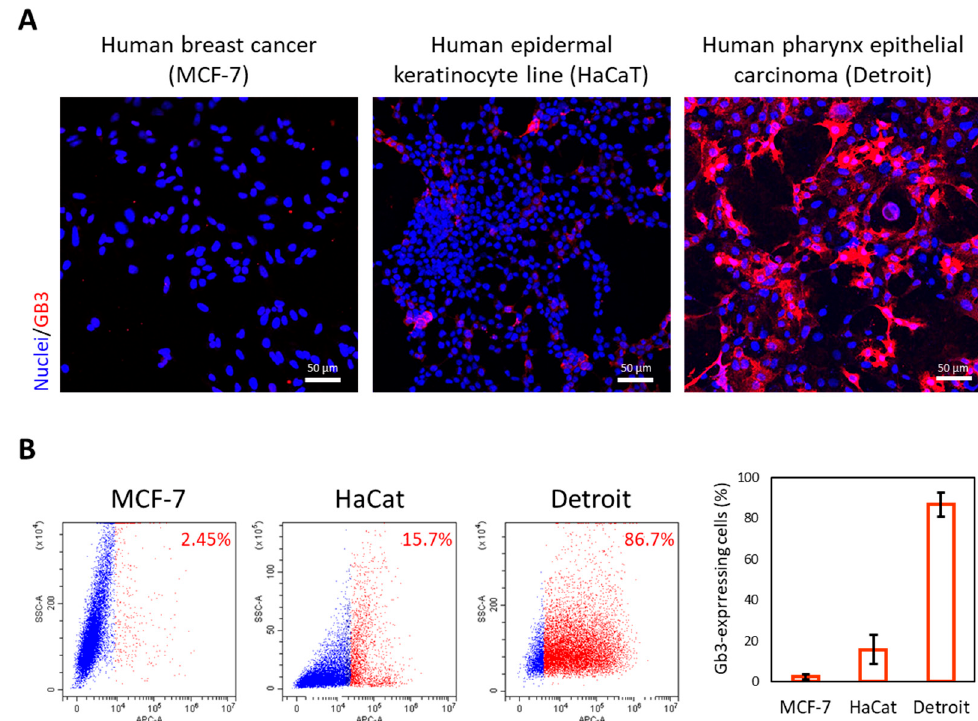
Figure 1. Detection of GB3 in human cell lines. ( A ) Confocal microscopy projection images of live human cell cultures immunostained with anti-CD77 recognizing GB3 (red channel). Cell nuclei are stained with Hoechst (blue channel). Scale bar = 50 μ m. ( B ) Flow cytometry analysis of these cultures confirmed that 86% of the malignant HNC neoplastic cells (Detroit 562), 16% of precancerous keratinocytes (HaCat), and 2.4% breast cancer cells (MCF7) presented detectable GB3 levels. The histogram shows the average of three experimental replicas where ca. 10 6 cells were analyzed per study (see Figure S1).